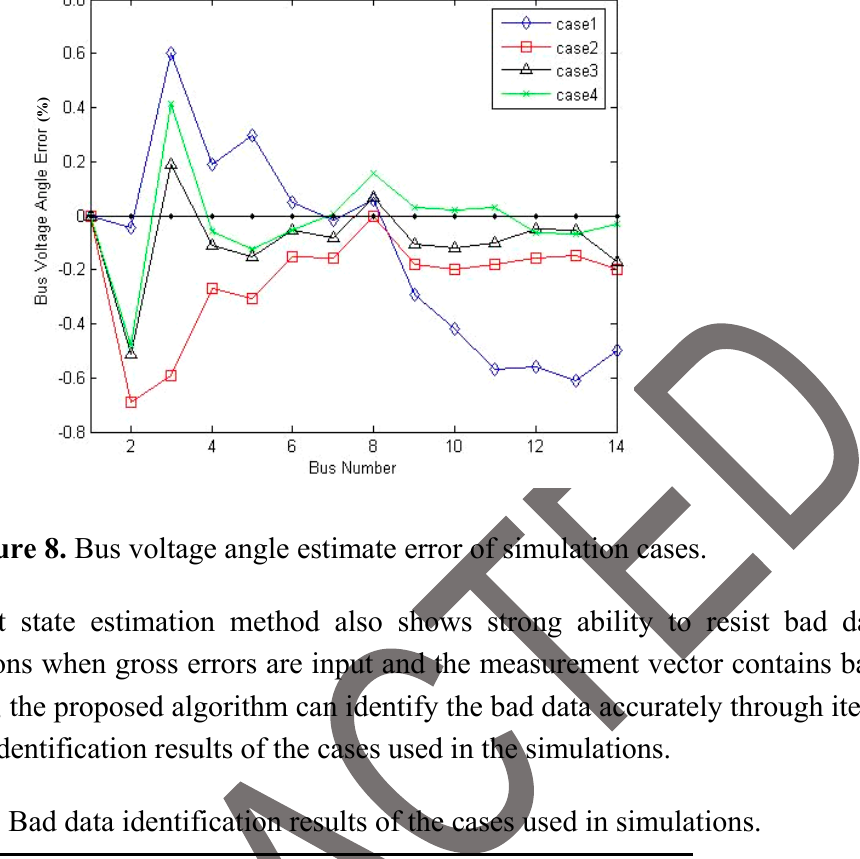
Table 4. Bad data identification results of the cases used in